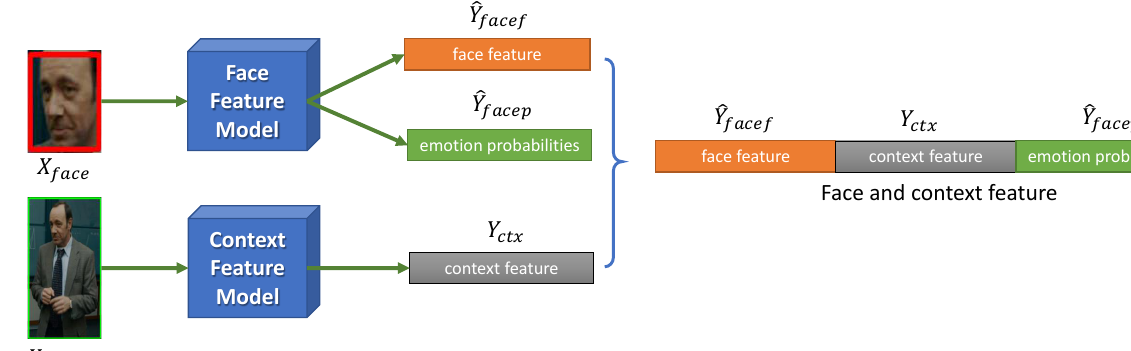
Figure 3. Face and Context Feature